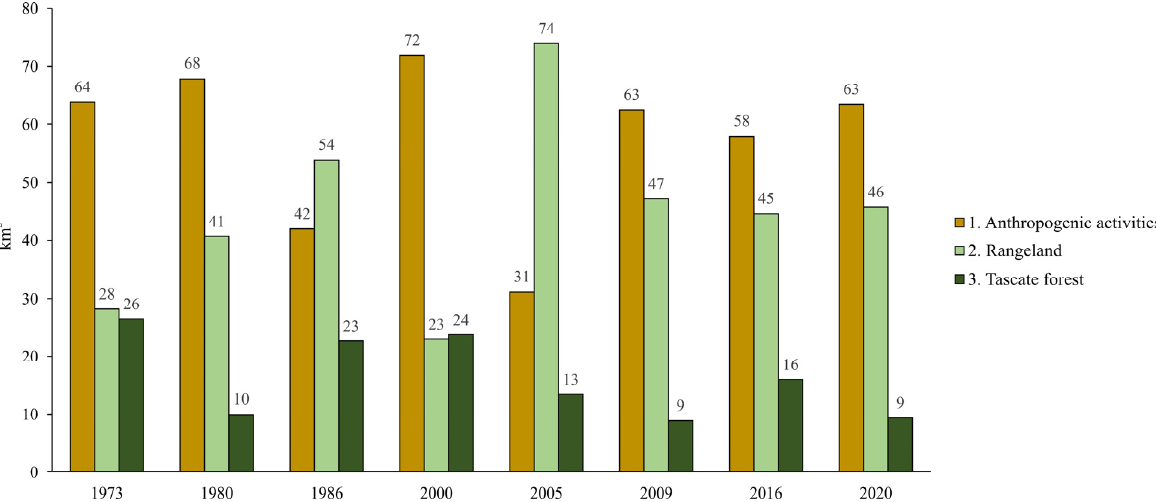
Figure 19. Land use coverage and changes in the study period, El Llano y Anexas, Bustamante, Tamaulipas, Mexico. Tamaulipas,